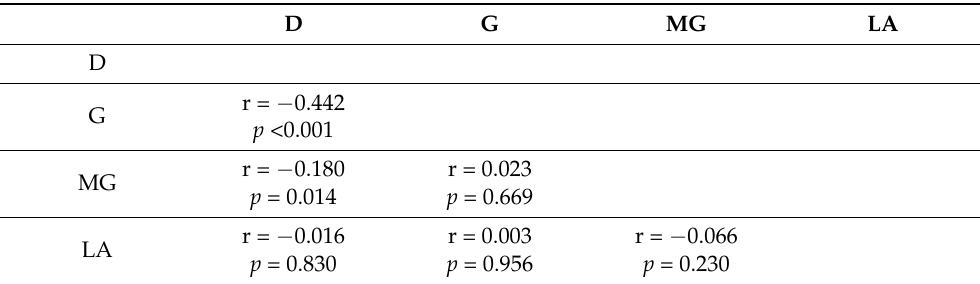
Table 5. Nonparametric variable correlations ( N = 223).